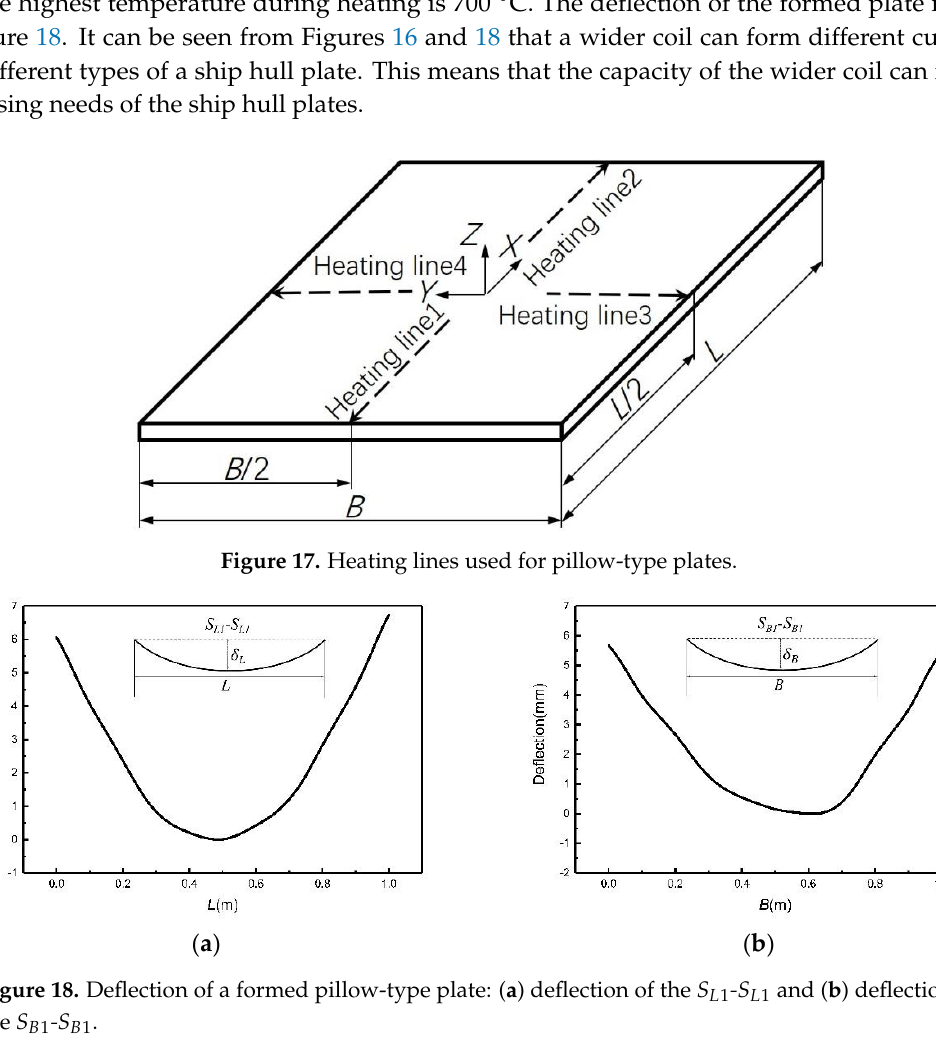
Figure 16. Transversal curvatures for different input powers.